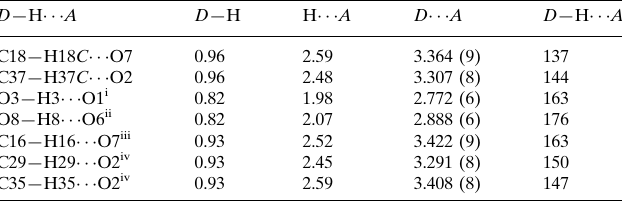
Hydrogen-bond geometry (A˚ , (cid:3)